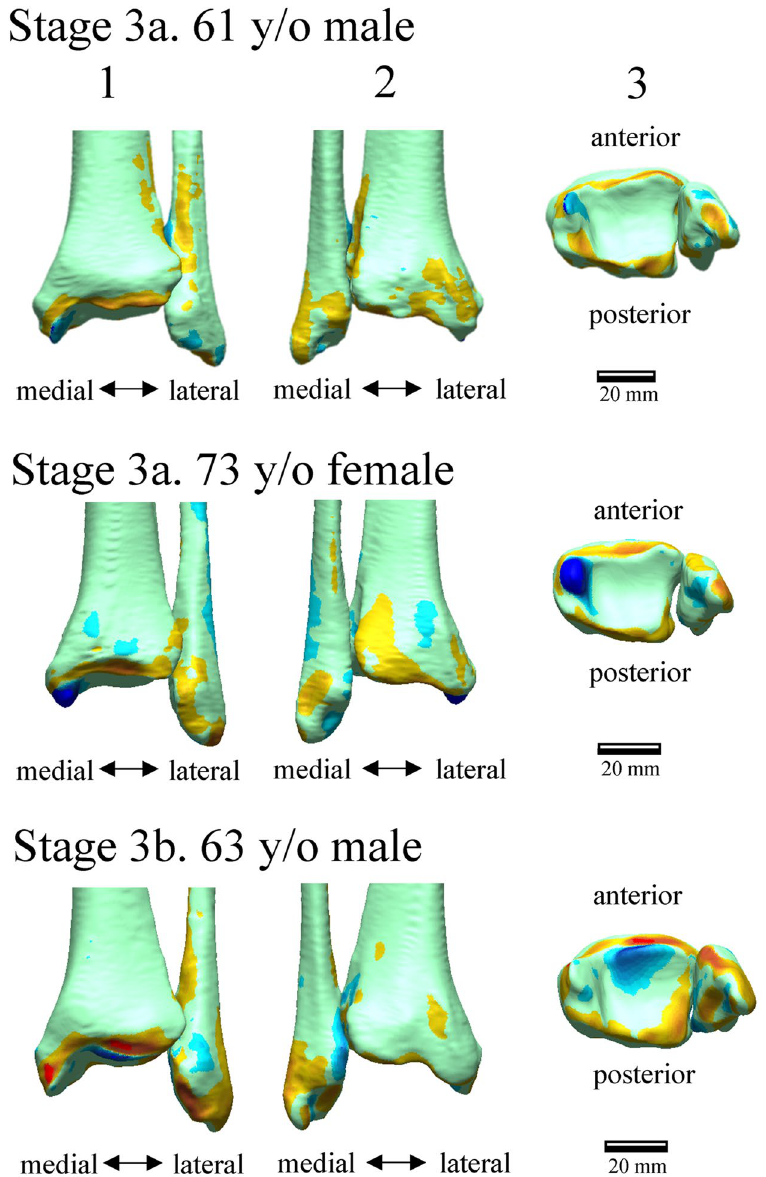
Figure 3. Deviation color maps of left–right comparisons of the tibia and fibula in the OA group. Six representative cases (the same cases as in Fig. 1) are presented. The red and blue colors are deviations of the OA surface outside and inside of the opposite surface. 1. Anterior view. 2. Posterior view. 3. Inferior view. y/o = years old. See text for more